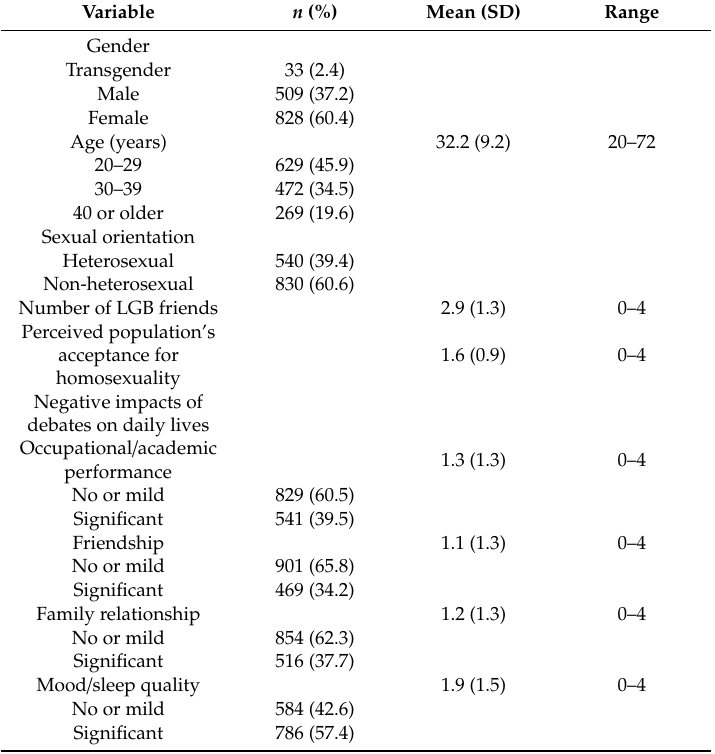
Table 1. Demographic characteristics, number of LGB friends, perceived population’s acceptance for homosexuality, and negative impacts of debates on daily lives ( N = 1370). Variable n